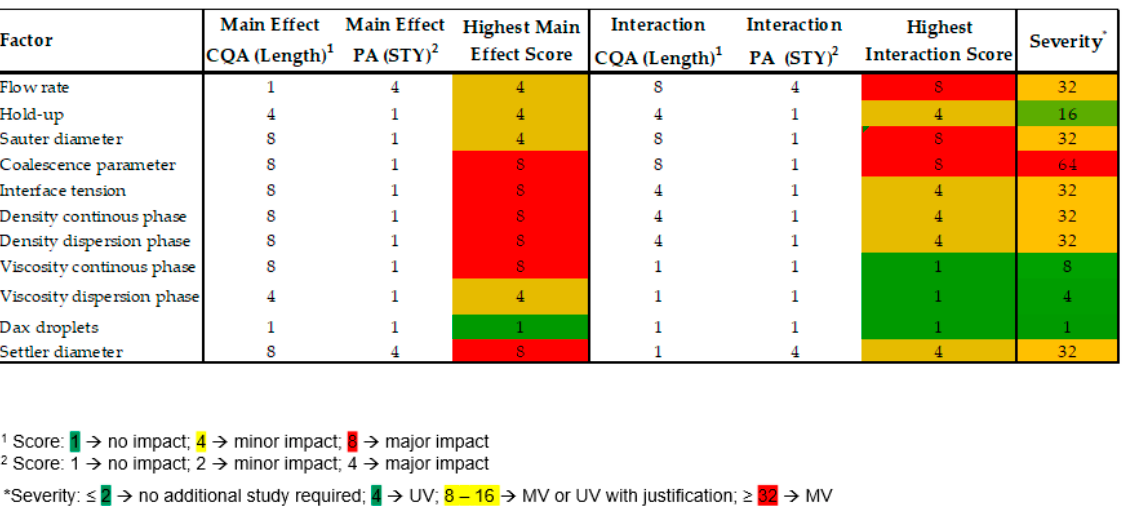
Figure 21. Quantitative risk assessment from OFAT and MFAT simulation study.